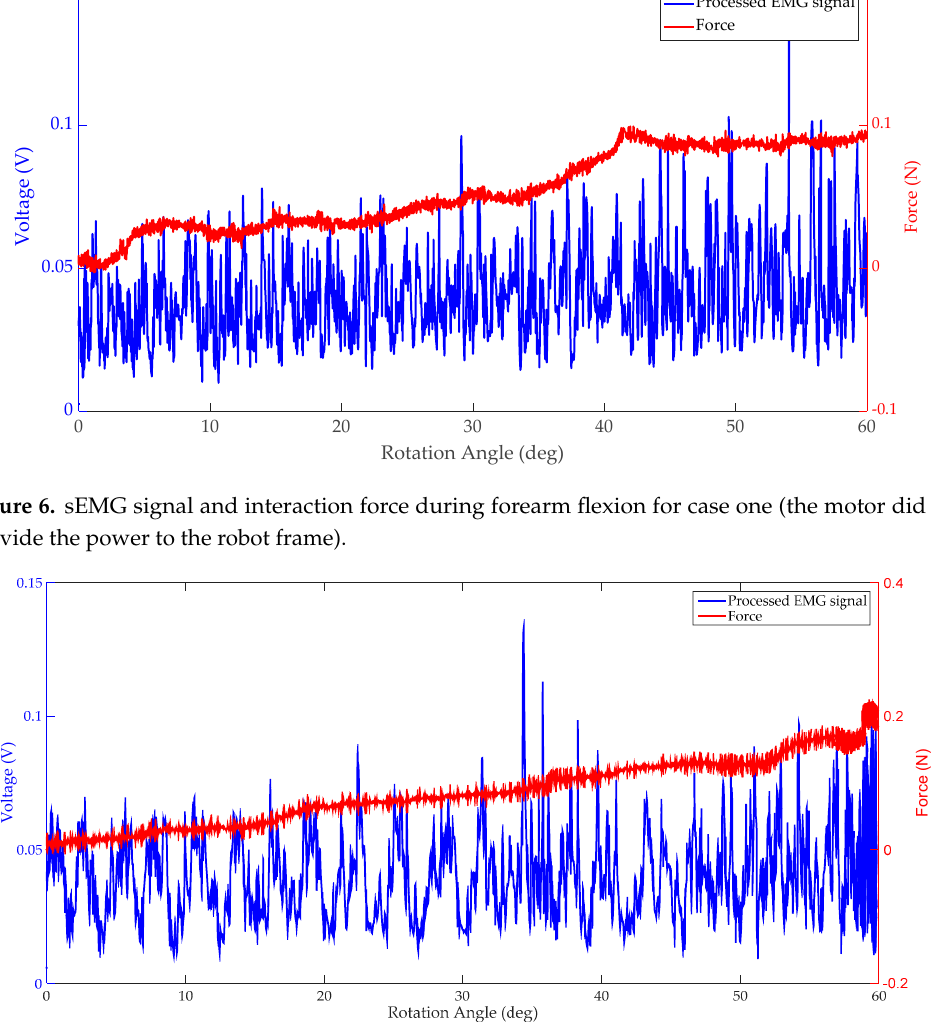
Figure 7. sEMG signal and interaction force during forearm flexion for case two (the motor provided the power to the robot frame while an impedance controller was applied).